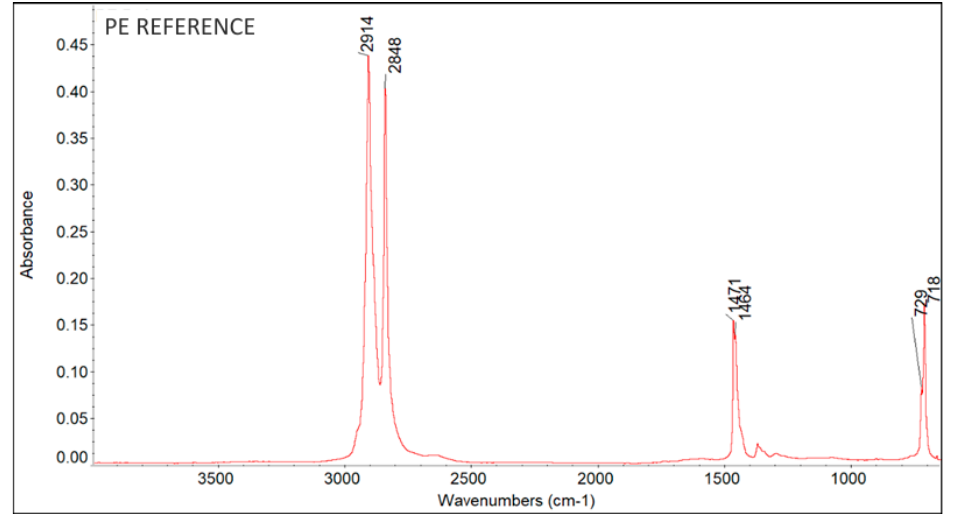
Figure 8. IR spectrum of the polyethylene reference foil PE Reference.